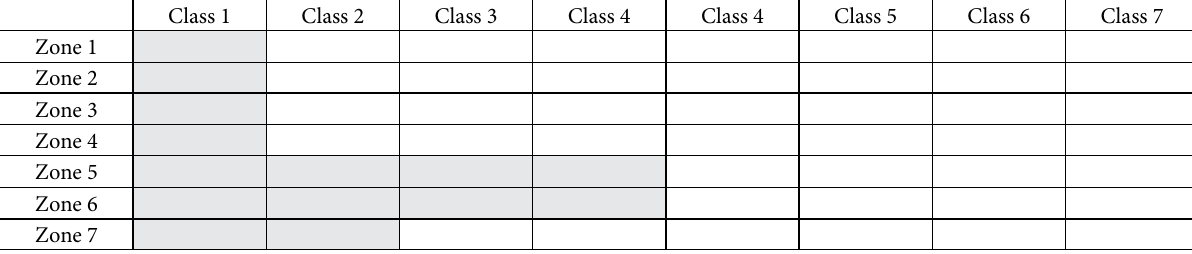
Fig. 8. Arrangement of the AE sensors on the surface of the beams and the max range of the measuring surface (measurements in cm) Table 3. Classes of signals (damage processes) registered in different measuring zones of one of the bridge beams under normal traffic